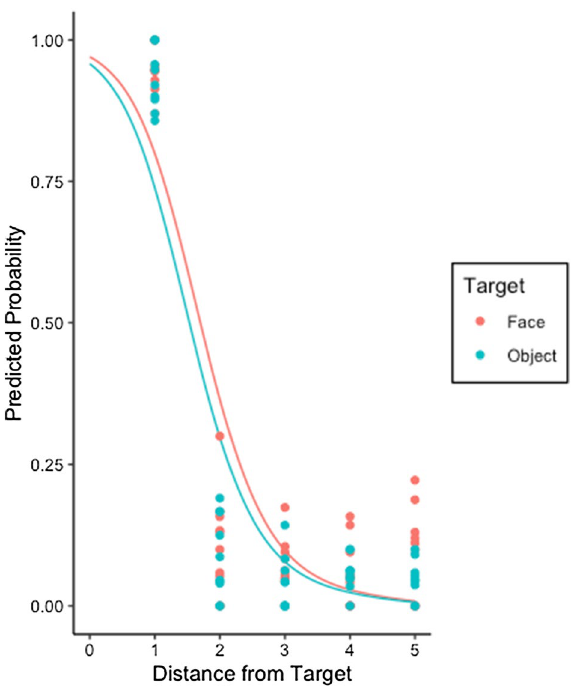
Figure 3. The likelihood that a participant will code the cursor as a hit in Experiment 2 for a face or inanimate object. The lines show the average marginal probabilities estimated by GLMM and the scattered points indicate the observed probability for each